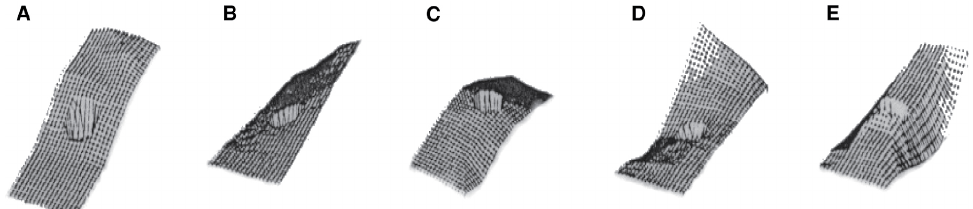
Figure 5: ESPI fringe patterns at different resonance modes (holed specimen). (A) First mode (B) second mode (C) third mode (D) fourth mode (E) fifth mode.